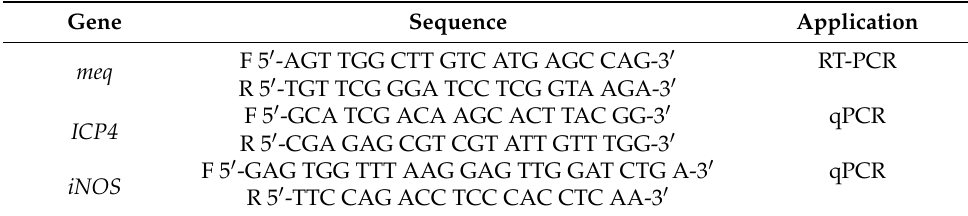
Table 2. Primers used for reverse transcription-polymerase chain reaction and quantitative poly- merase chain reaction